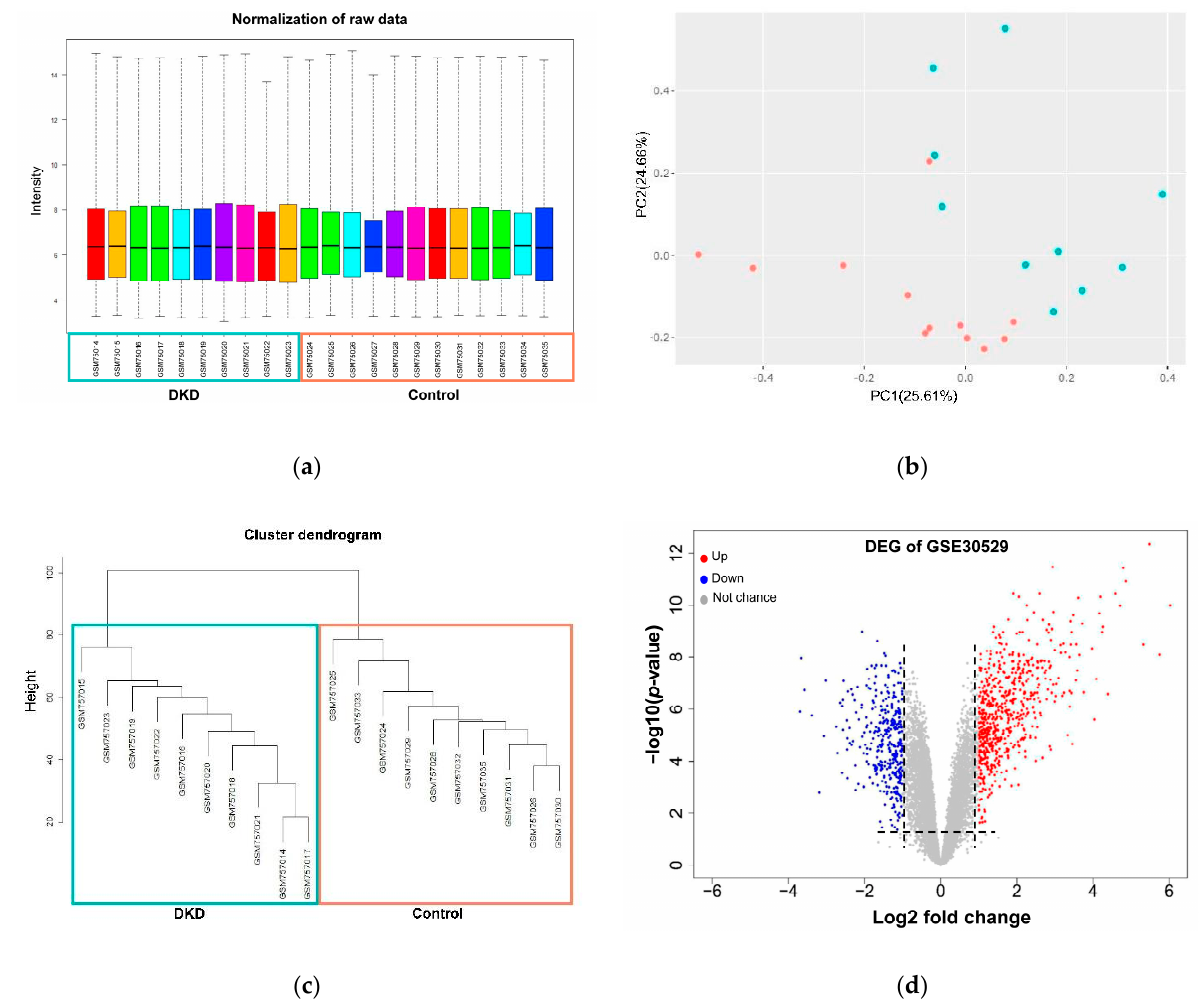
Figure 2. Pre-processing of GSE30529 dataset raw microarray data and differential expression analysis. ( a ) Boxplot of normalized raw data contrasting human patient healthy and DKD samples from kidney tubule. ( b ) PCA plots depict similarities and differences among DKD and control samples after data normalization. ( c ) WGCNA clustering represents 20 gene modules and two clusters. ( d ) Volcano plot of DEG, red (up) and blue (down) colored dots indicate the DEGs, while the grey dots represent genes without expression changes (NC) among DKD and control samples.